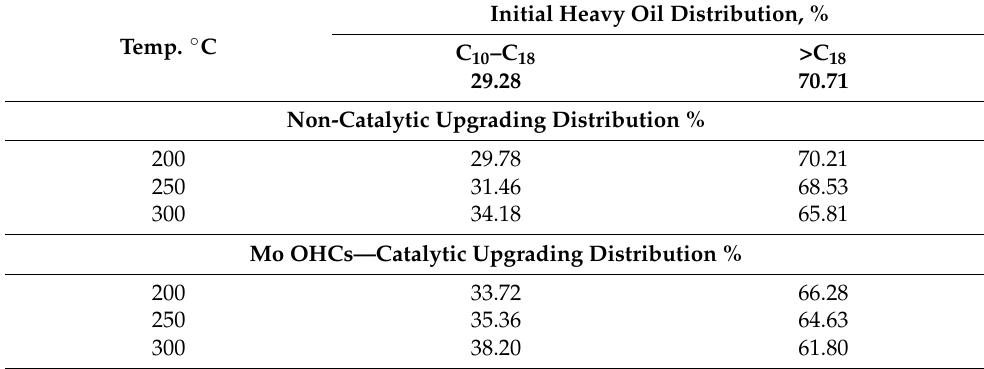
Table 4. Carbon number distribution percentage before and after catalytic and non-catalytic upgrading.